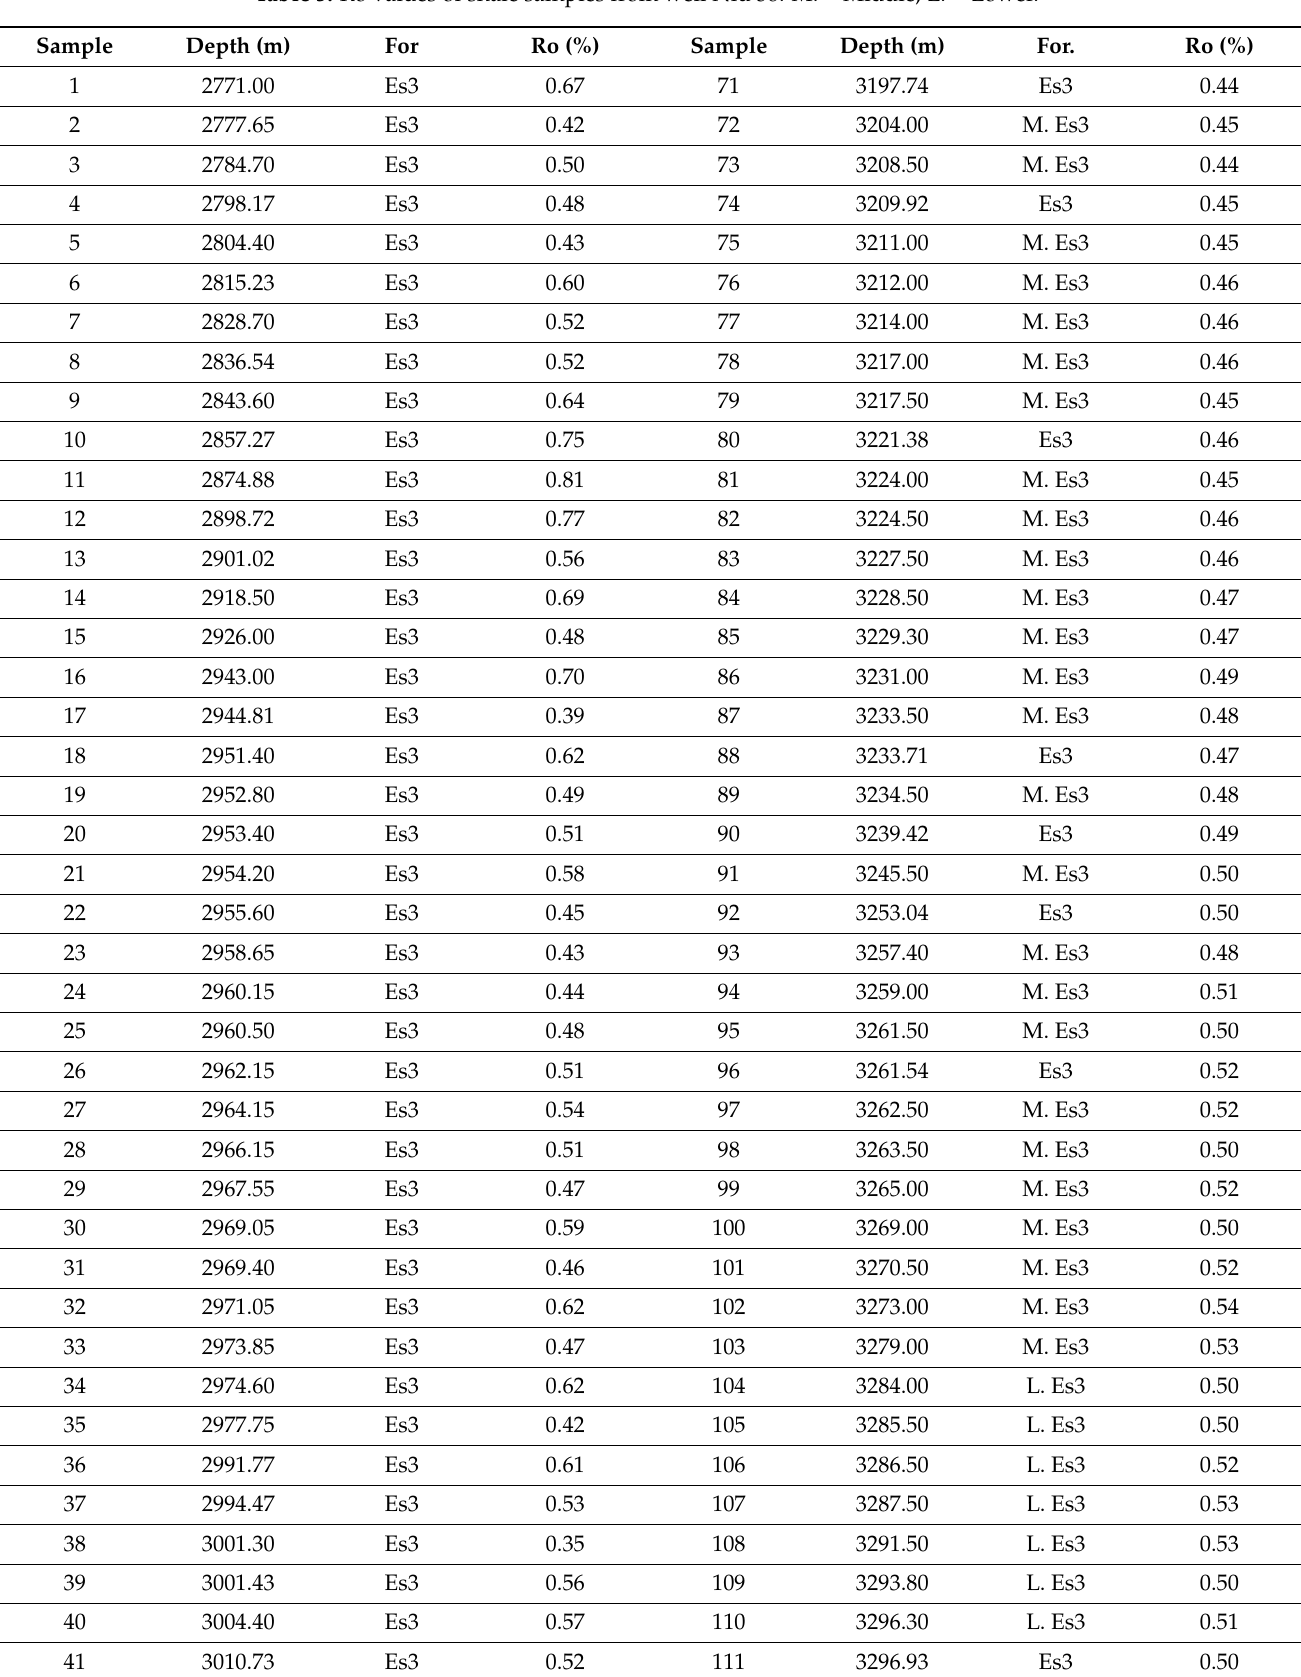
Table 3. Ro values of shale samples from well Niu 38. M. = Middle, L. =